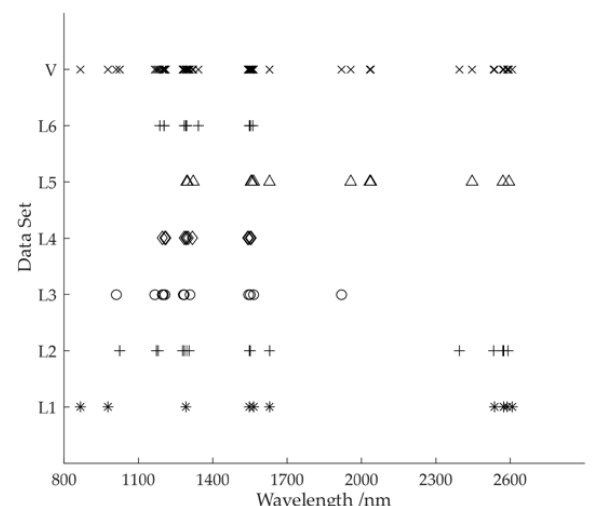
Figure 6. The variables selected by the DWT-BOSS coupling algorithm. Note: L1 refers to the reconstructed spectral average after one-layer wavelet transform, L2 to L6 are analogous to L1. V is the optimal variable set. Different graphs represent different levels of decomposition.